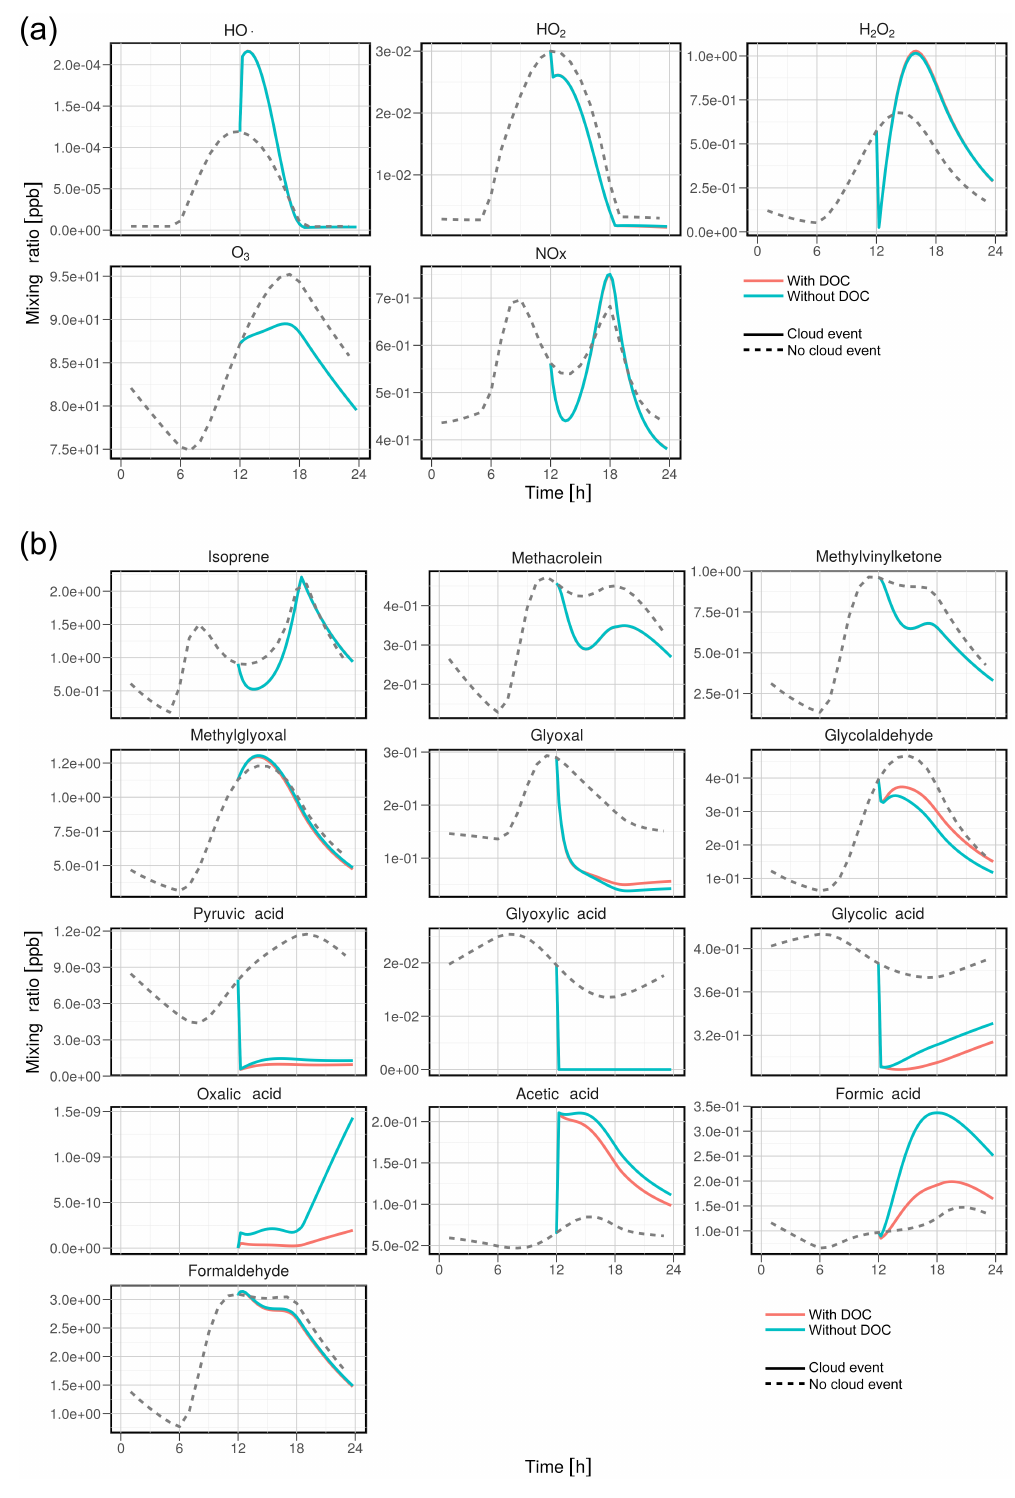
Figure 3. Time evolution of the gas phase mixing ratios without the cloud (dashed lines) and during the cloud (continuous line). The cloud simulations are depicted with (red lines) and without (blue lines) DOC. Please note that for most plots, the red line is hidden by the blue